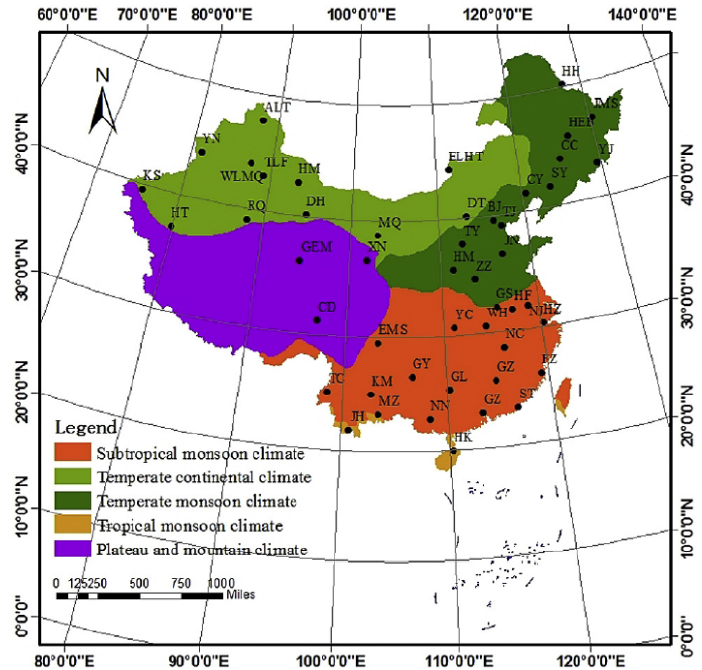
Figure 5. Climate zone distribution of China.